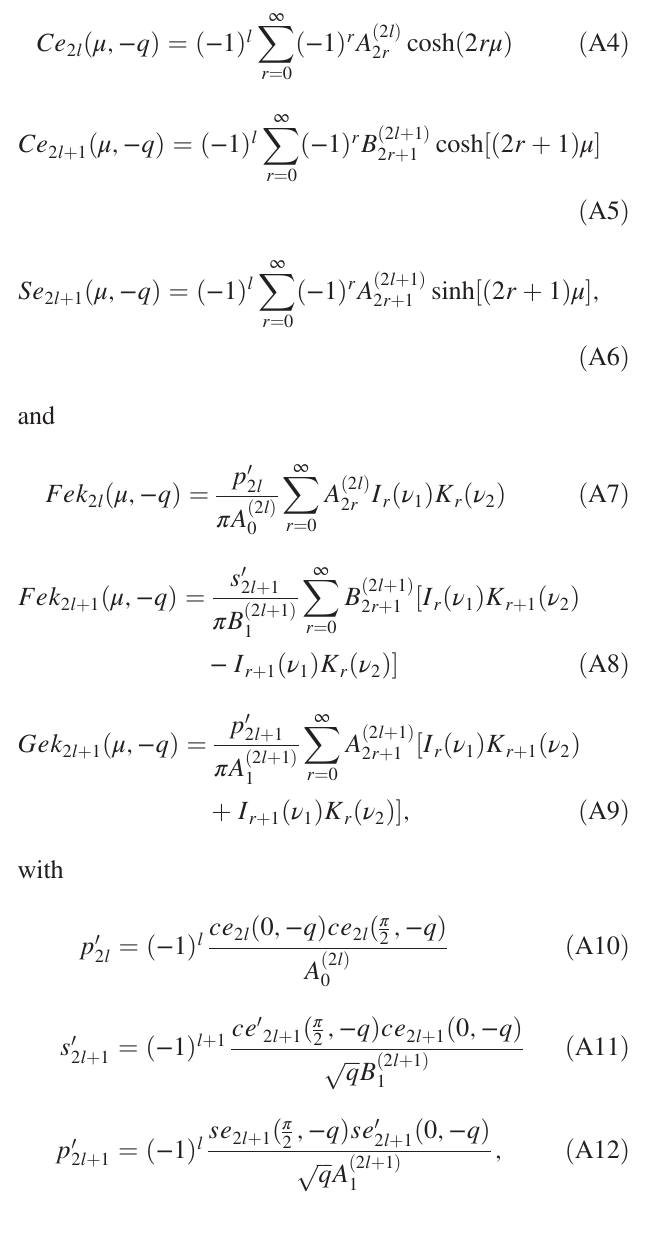
FIG. 5. Adimensional equivalent radius b q r for the vertical and horizontal plane compared with Eqs. (39) and